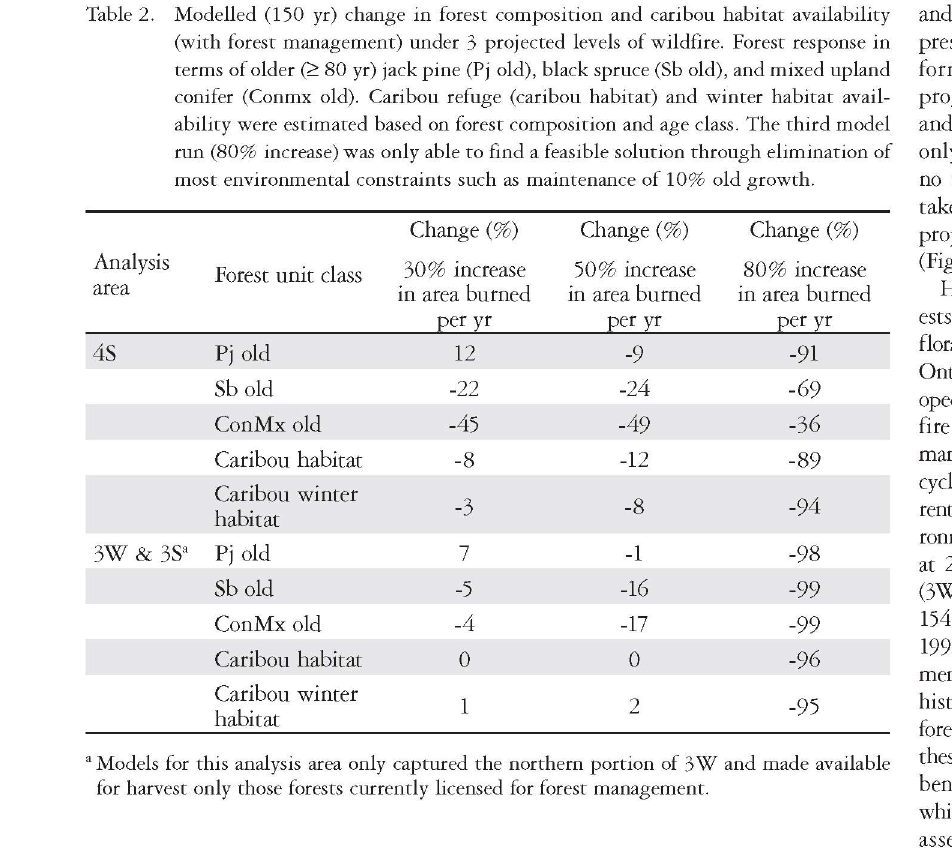
Table 2. Modelled (150 yr) change in forest composition and caribou habitat availability (with forest management) under 3 projected levels of wildfire. Forest response in terms of older (> 80 yr) jack pine (Pj old), black spruce (Sb old), and mixed upland conifer (Conmx old). Caribou refuge (caribou habitat) and winter habitat avail ability were estimated based on forest composition and age class. The third model run (80% increase) was only able to find a feasible solution through elimination of most environmental constraints such as maintenance of 10% old